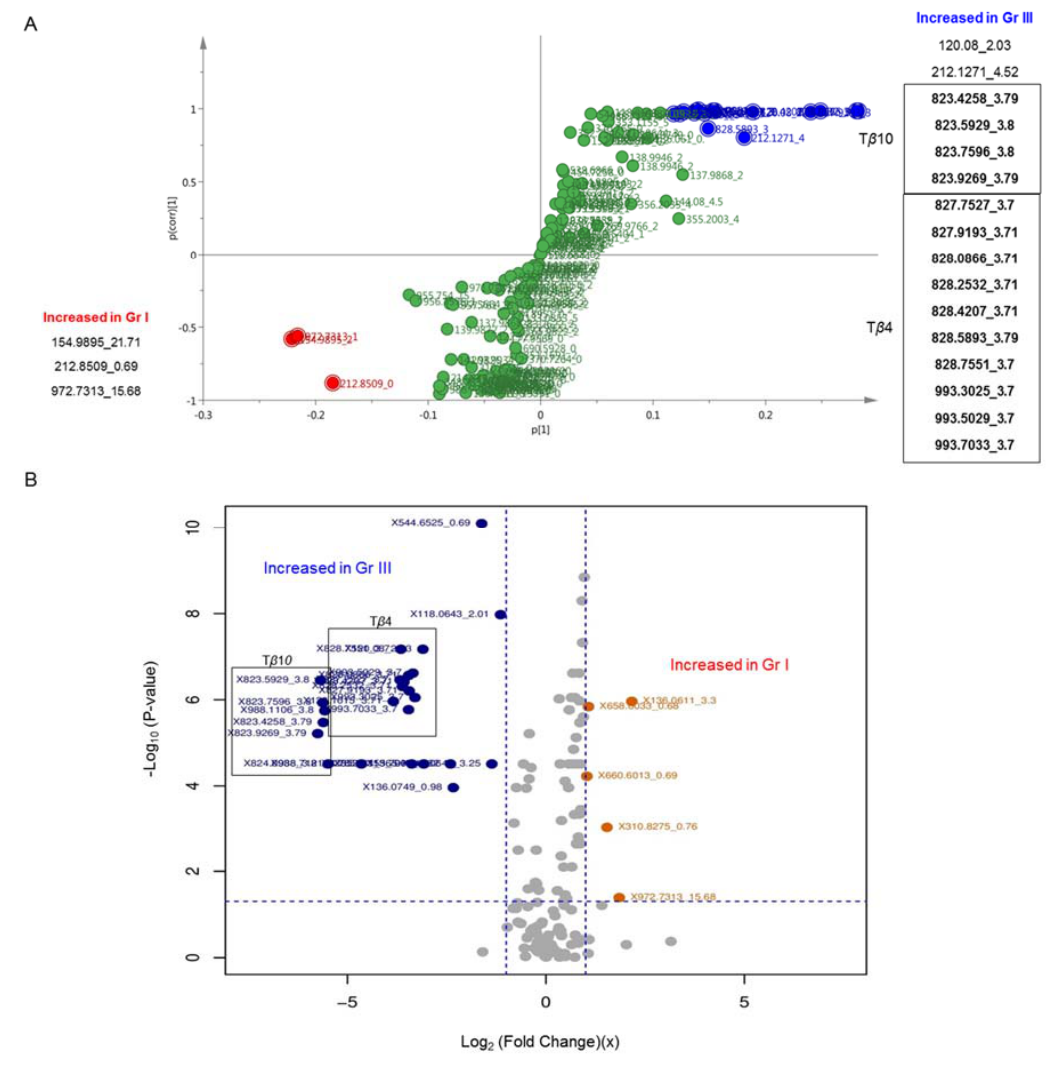
Figure 6. Comparison of the grade I (RT4) versus grade III (T24) cell groups and the significant MS analysis features. T β 4 and T β 10 charged peaks, and their respective isotopes, were found to be elevated in the grade III (T24) UBC cell group, using both univariate and multivariate approaches. Blue: increased in grade III (T24), Red: increased in grade I (RT4). ( A ) S ‐ plot from OPLS ‐ DA modeling multivariate approach. ( B ) Volcano plot of log 2 [fold change (FC) (x)] versus p ‐ values, and the selected variables with p < 0.05 and FC > 2, or < 0.5 (univariate approach). Gr: (malignancy) grade.